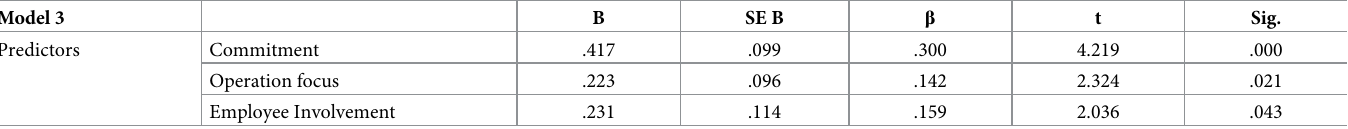
Table 5. Coefficients of multiple regression model.